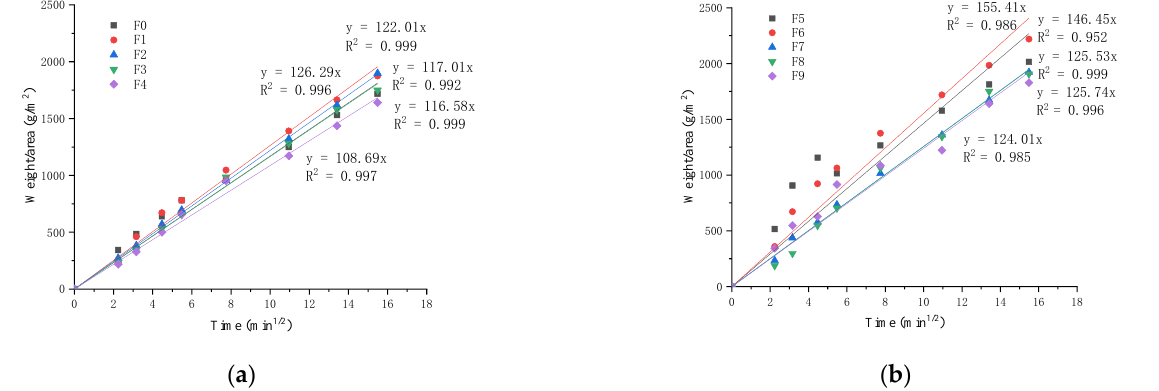
Figure 8. Capillary water absorption of NS-modified mortar: ( a ) 50% FA and ( b ) 60% FA.